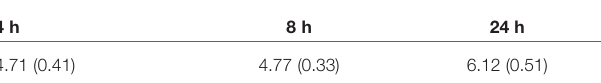
TABLE 1 | Number of Salmonella organisms in cecal contents of chickens after oral administration on day 1 of age a . Mean log10 CFU of Salmonella enterica serovar Enteritidis of tissue (SEM) at h